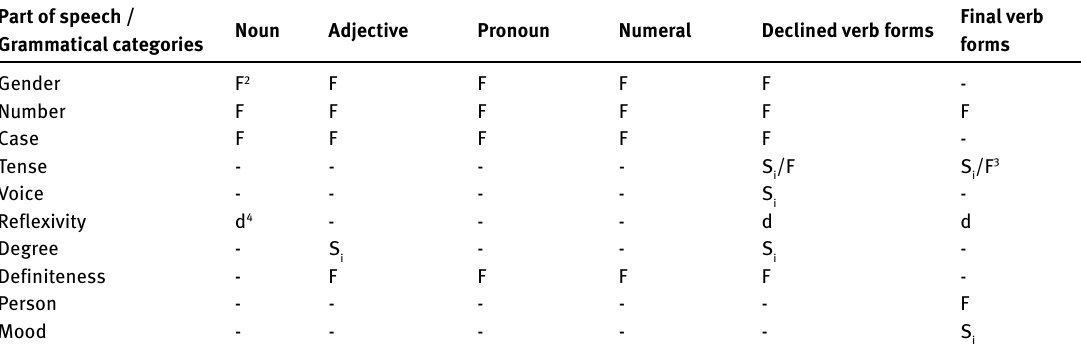
Table 1. Grammatical categories across different parts of speech234 Part of speech